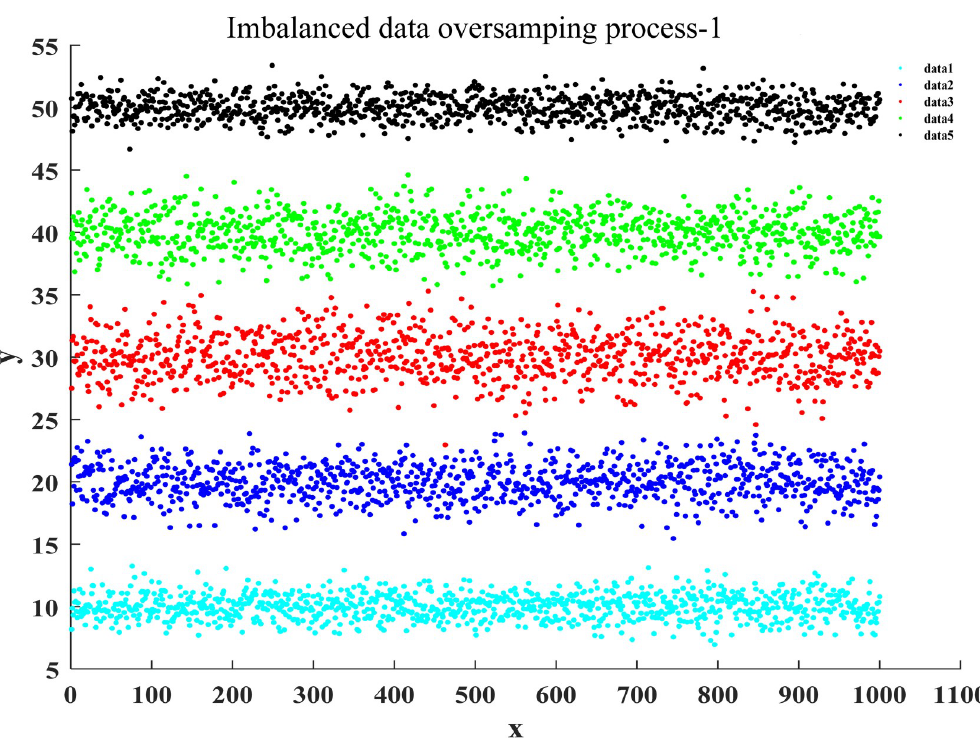
Fig 4. Data sorting of oversampling for imbalanced